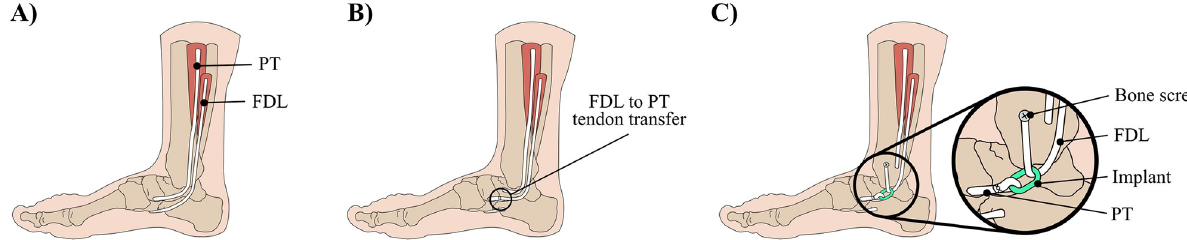
Fig 1. Treatment options for adult acquired flatfoot deformity. Drawings of (A) an arched foot, (B) a traditional FDL to PT tendon transfer surgery, and (C) our proposed implant-modified FDL to PT tendon transfer